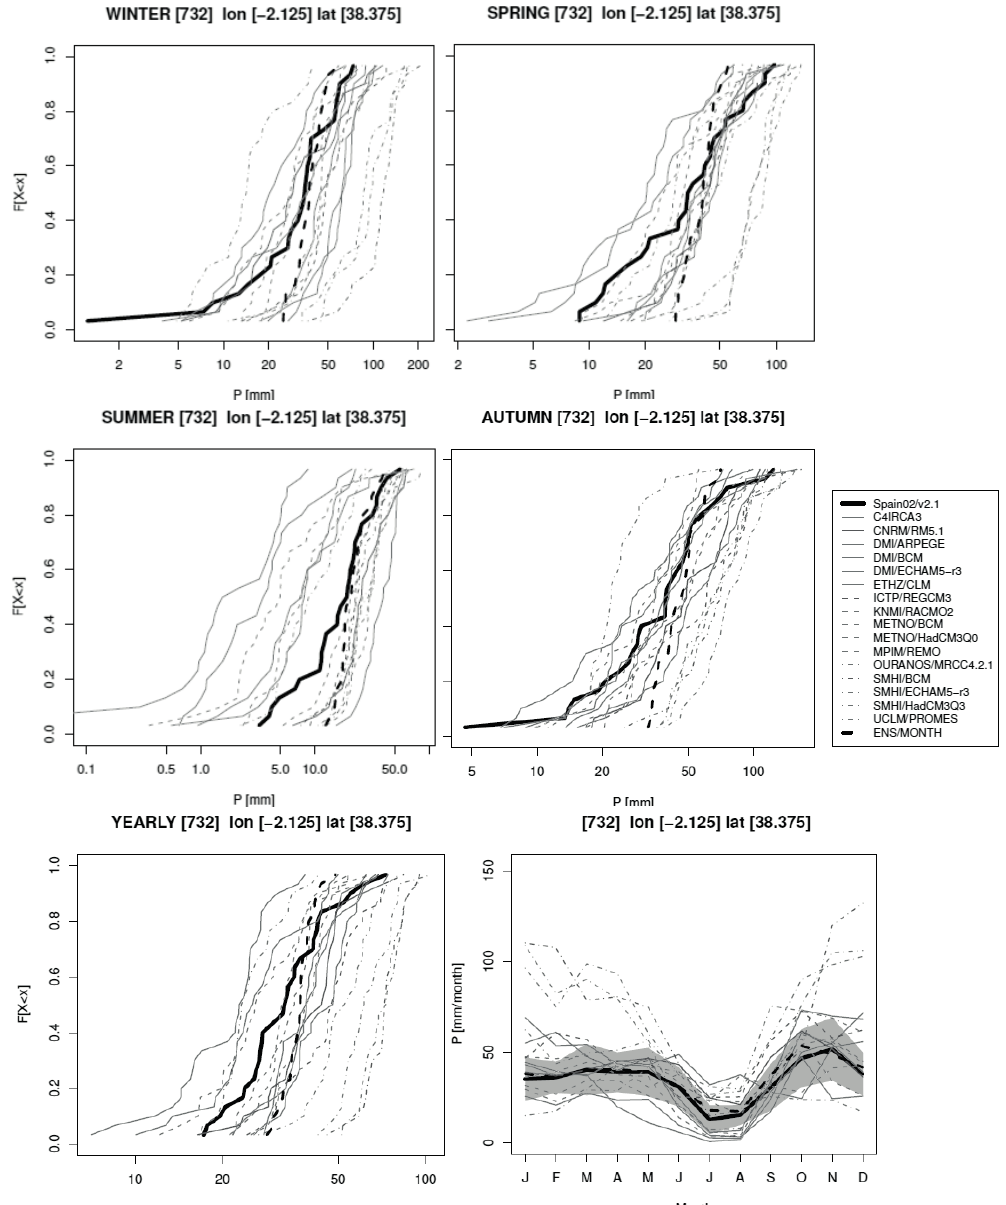
Fig. 2 Seasonal and annual CDFs of rainfall on site 732, from observed dataset (in black), ensembles (dashed black) and RCMs. Time period: